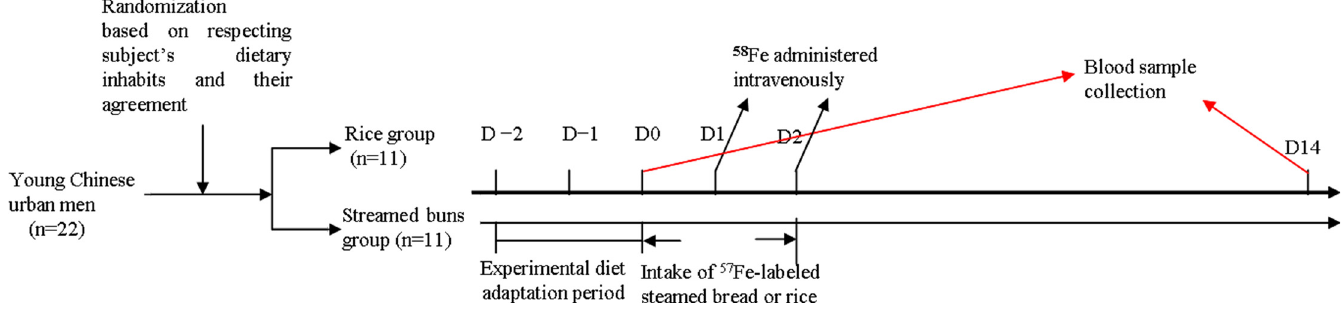
Fig 1. Experimental